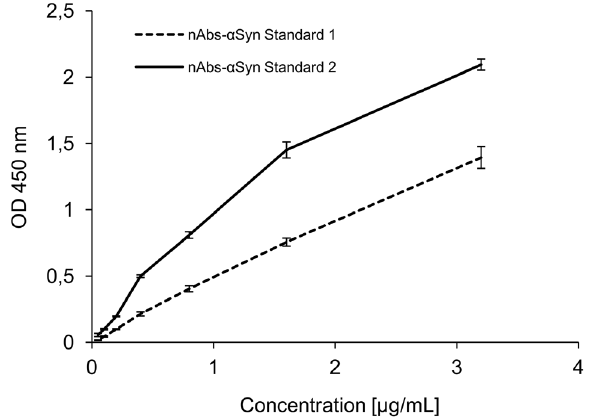
Figure 5. Results of the ELISA of purified a -Syn-nAbs standards from two different preparations of one IvIG batch quantified by optical density (OD; mean ¡ standard deviation) at 450